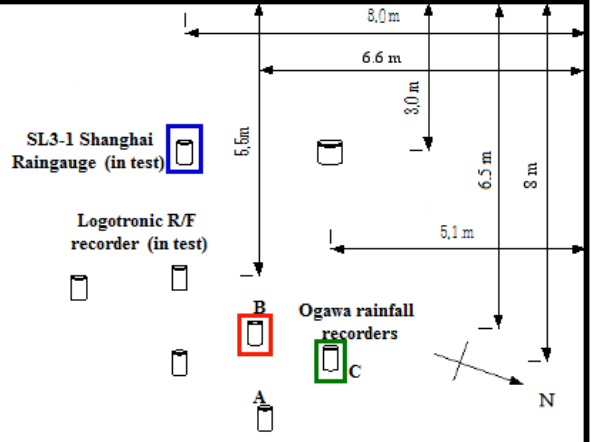
Figure 2. The western corner of the Hong Kong Observatory field test site where the SL3 (blue box), the LGO (red box) and the OSK (green box) are located. The distances of each instrument from the field site borders are also indicated.